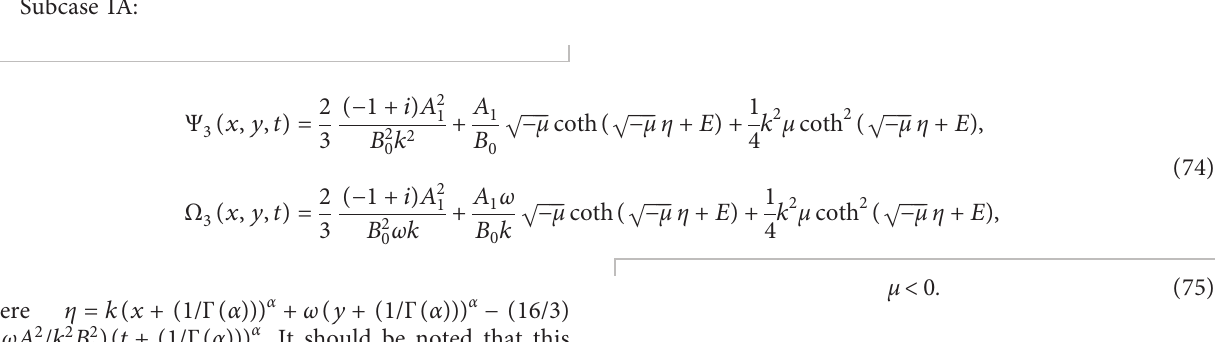
Figure 4: The plot of (69) Ψ (c) 2D plot (red α � 0 . 5, blue α � 0 . 75, and green α � 0 .